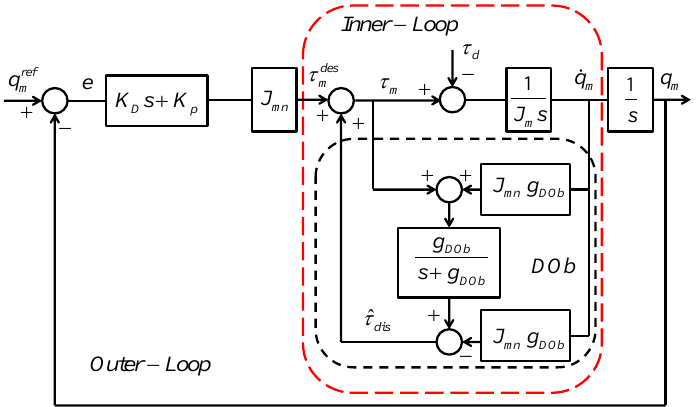
Figure 3. Block diagram of a DOb-based robust position control